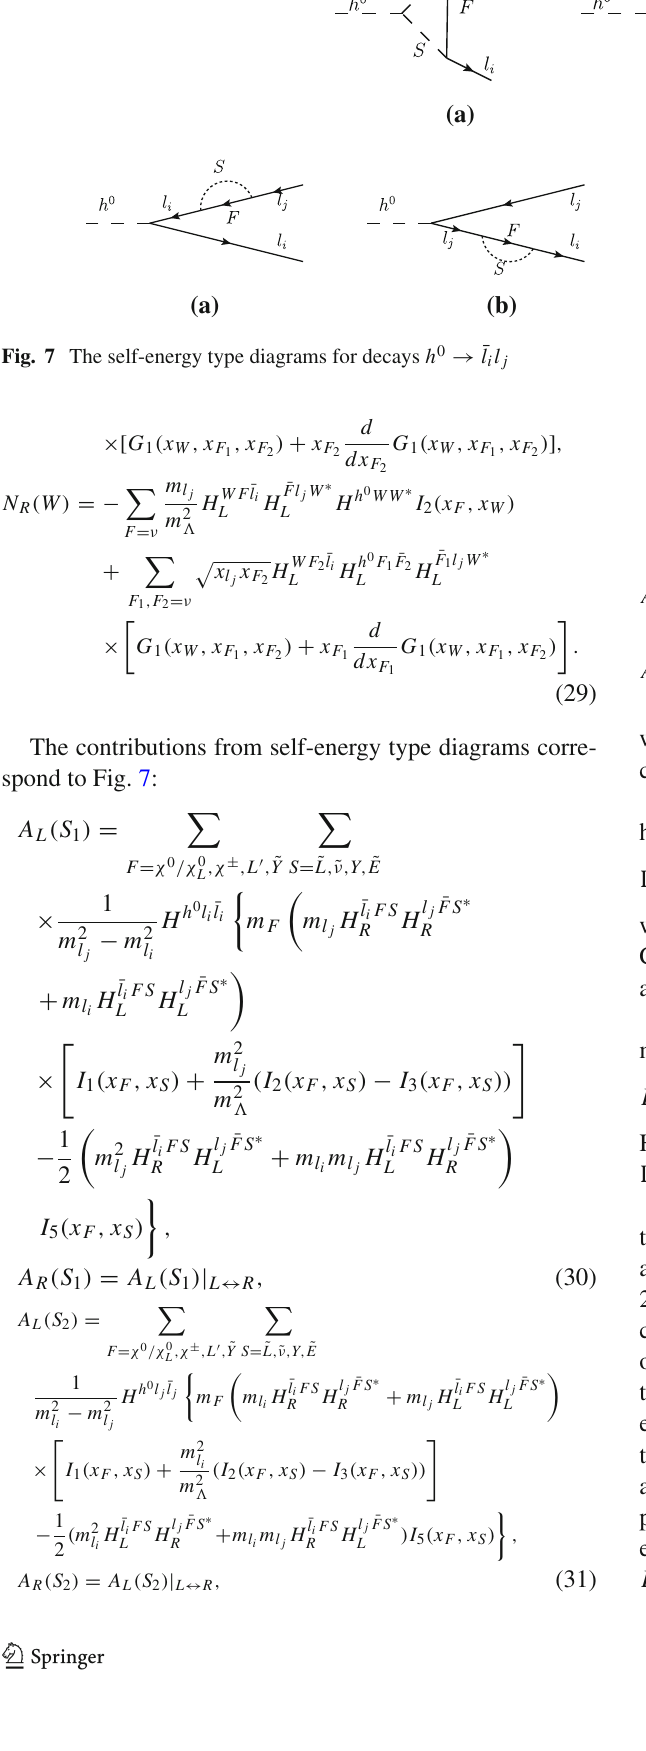
Fig. 6 The triangle type diagrams for decays h 0 → ¯ l i l j